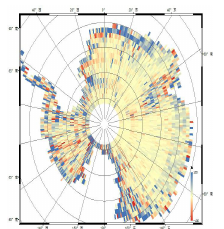
Figure 2. Difference in cycle 8 and cycle